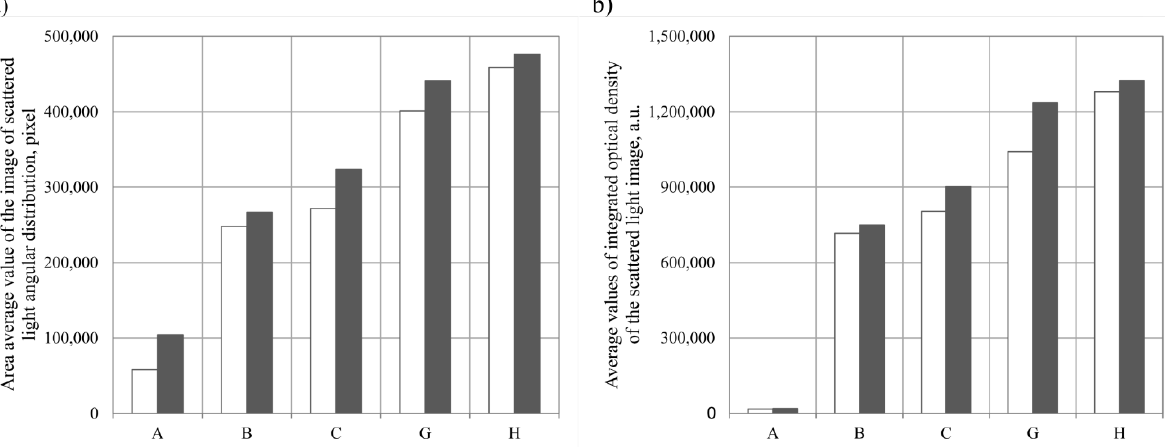
Figure 6. Mean values of the area (bright areas) of scattered light images ( a ) and the total light intensity (bright areas) of scattered light images ( b ) obtained for selected glass workpieces.